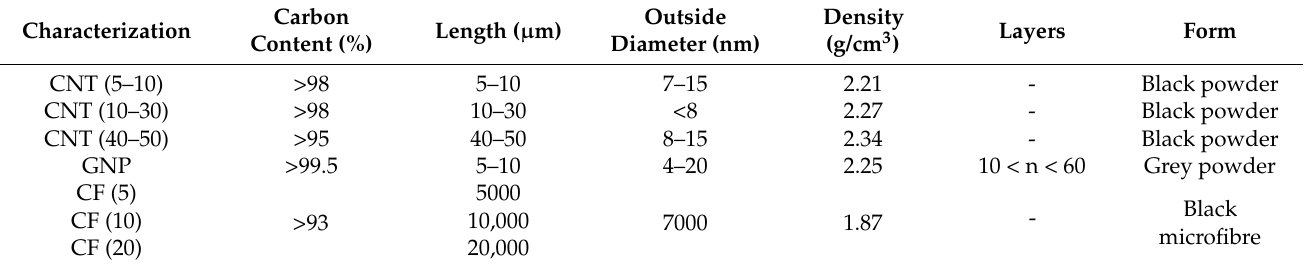
Table 1. Characterization of multi-wall carbon nanotube (MWCNT), graphene nanoplatelets (GNP), and short carbon fibre